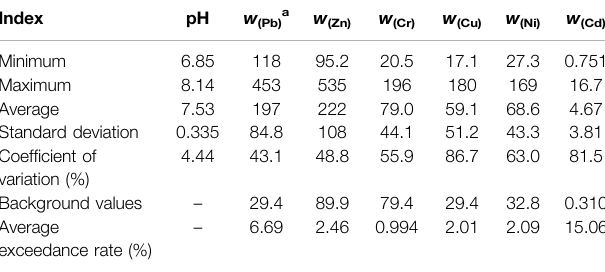
TABLE 3 | pH and heavy metal content in super fi cial